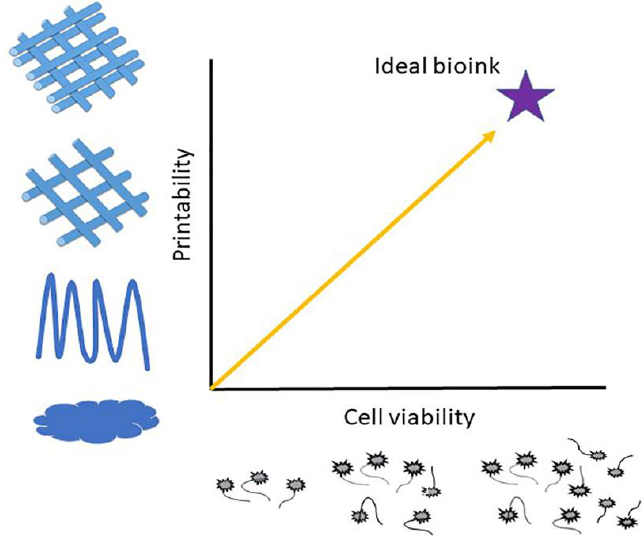
Figure 4. The biofabrication window for biomaterials.